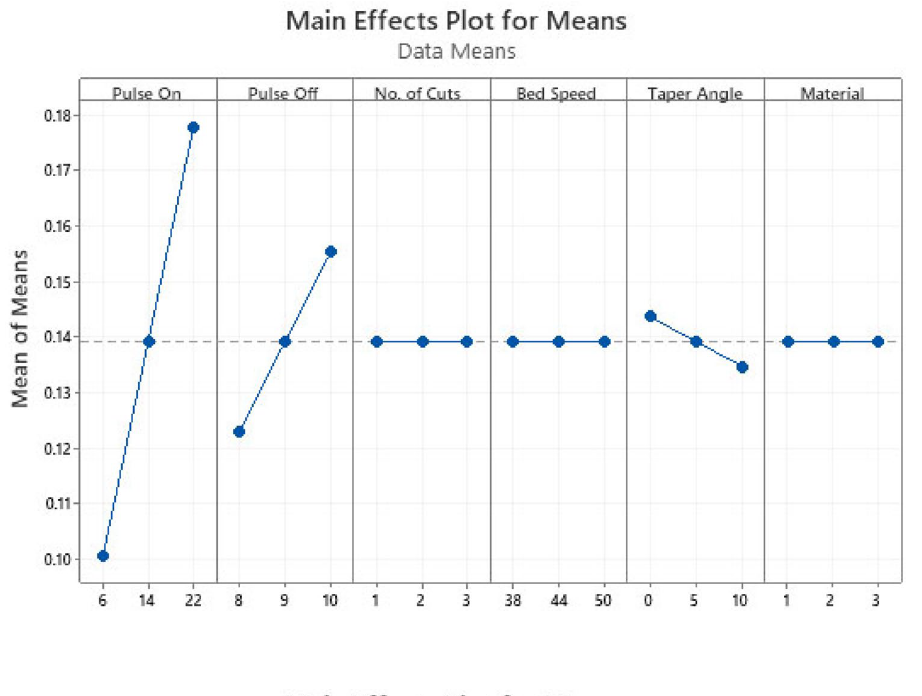
Fig. 13 Main effects plot for means ( R ) a